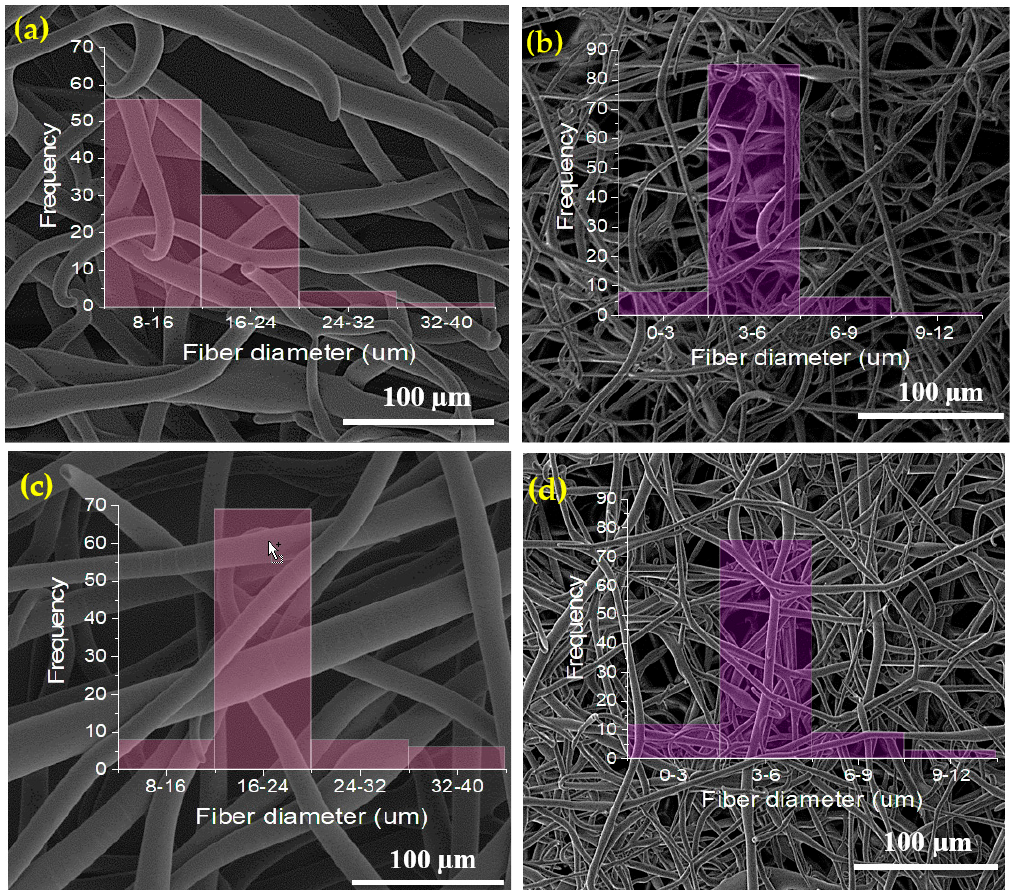
Figure 1. SEM images and corresponding histograms of the diameter distribution of electrospun phospholipid fibers prepared using limonene ( a ) and isooctane ( b ) as solvents encapsulating vanillin ( c ) and curcumin ( d ).